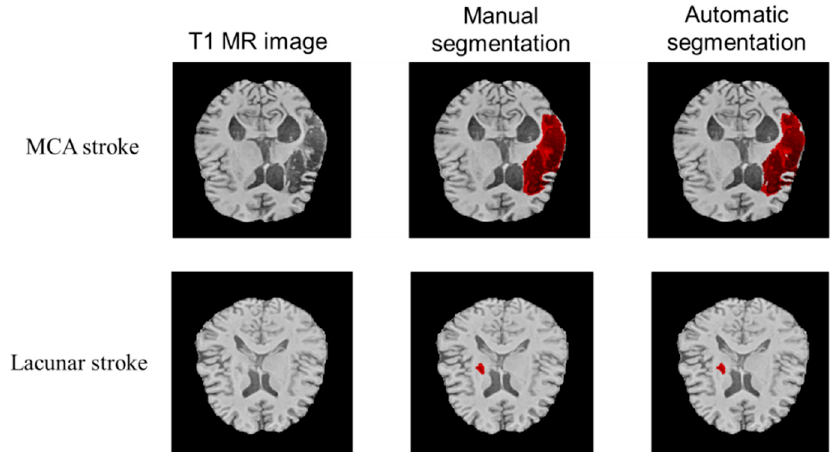
Figure 3. Axial sections showing examples of manual and automatic segmentation. The top row depicts the segmentation performance for a Middle Cerebral Artery (MCA) stroke and the bottom panel demonstrates performance for a lacunar stroke.